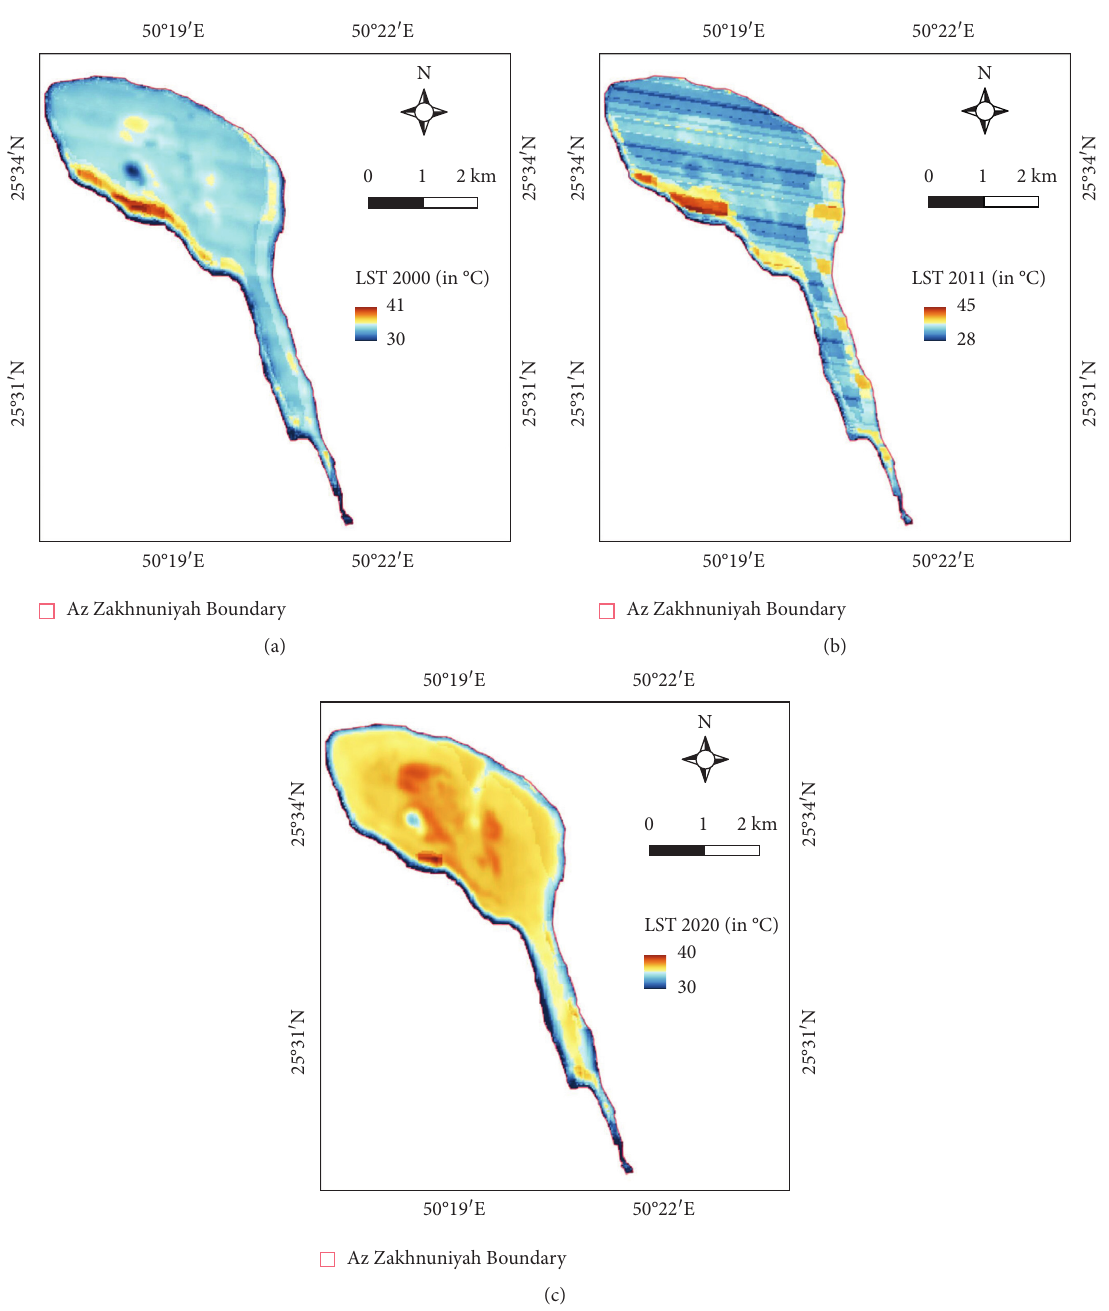
Figure 13: LST map ( ° C) of study area for (a) 2000, (b) 2011, and (c)